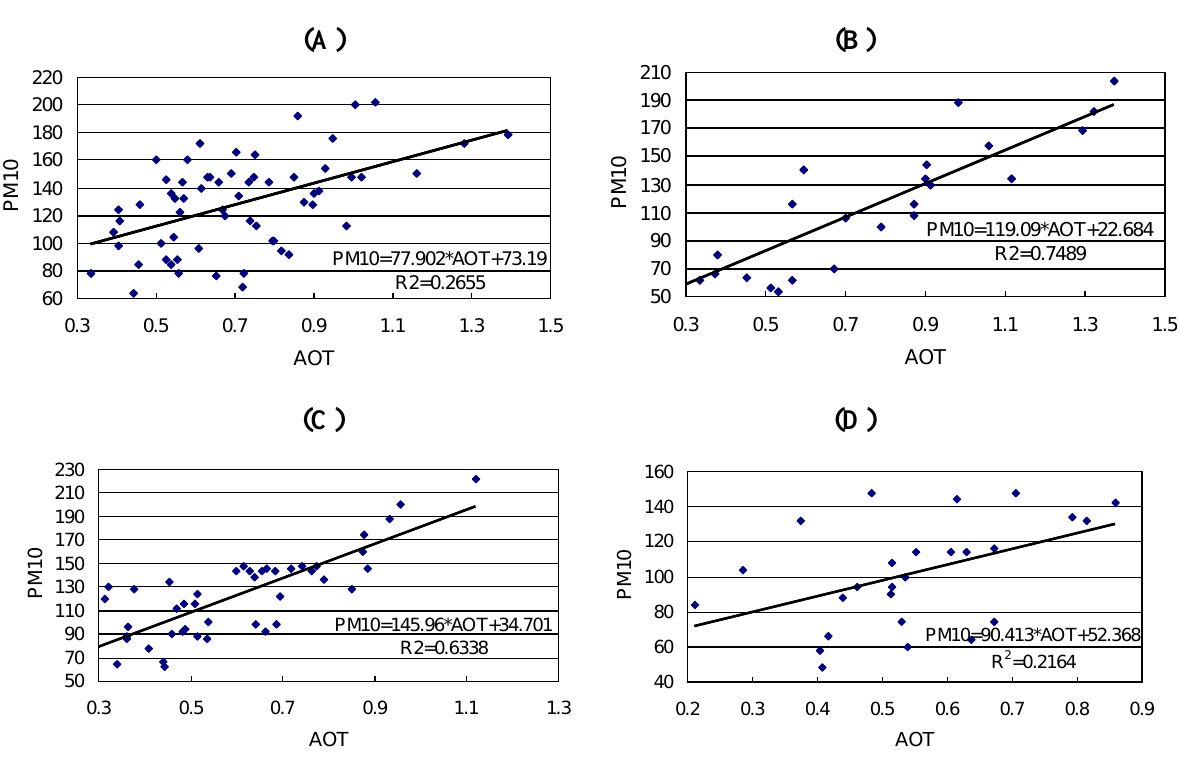
and AOT by season and its relationship with 10